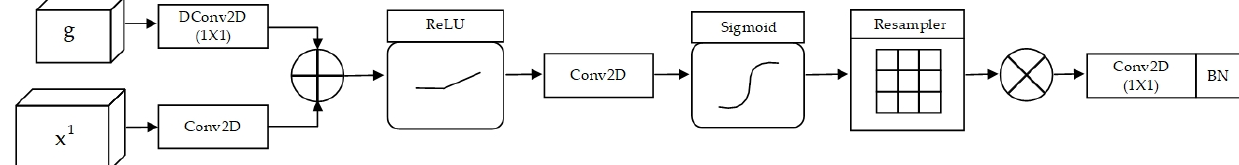
Figure 7. Structure of attention block.